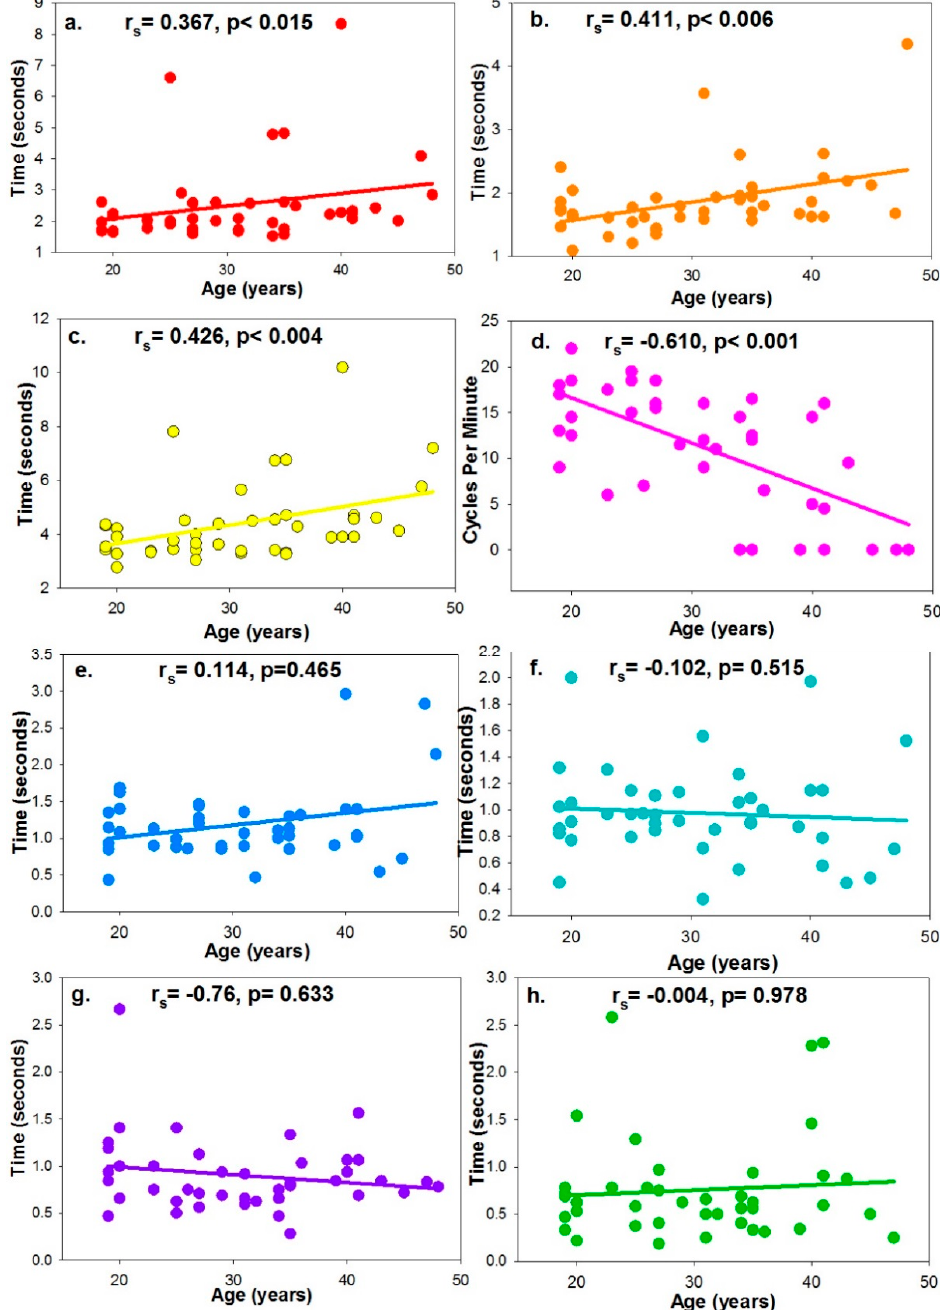
Figure 7. The correlation coefficient between age and ( a ) Time for Accommodation, ( b ) Time for Disaccommodation, ( c ) Objective Time for Accommodative Change, ( d ) Accommodative Facility, ( e ) Novel Latency of Accommodation, ( f ) Novel Latency of Disaccommodation ( g ) Latency of accommodation, and ( h ) Latency of Disaccommodation.